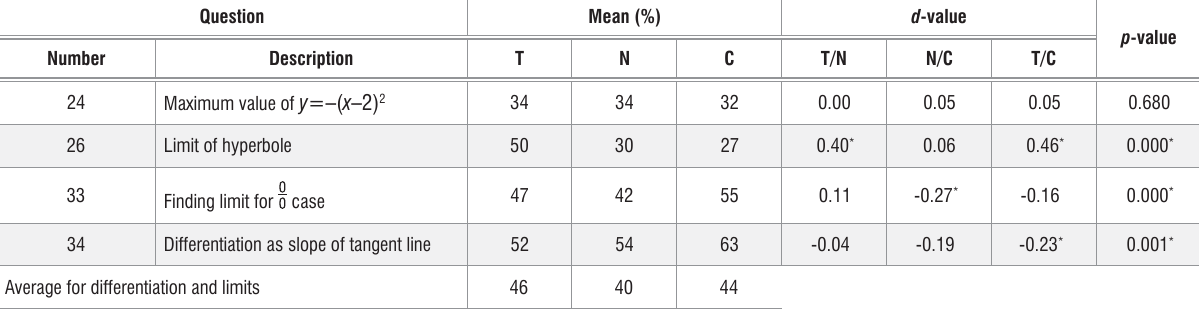
Finding limit for case